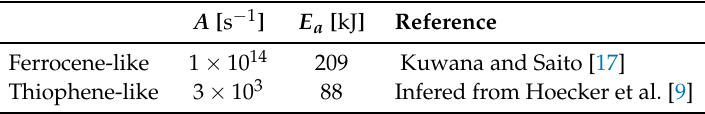
Table 1. Decomposition rates of the iron